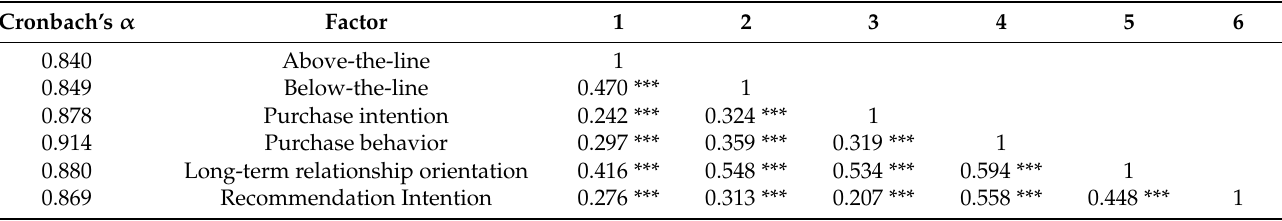
Table 3. The correlation matrix of the measurement model.